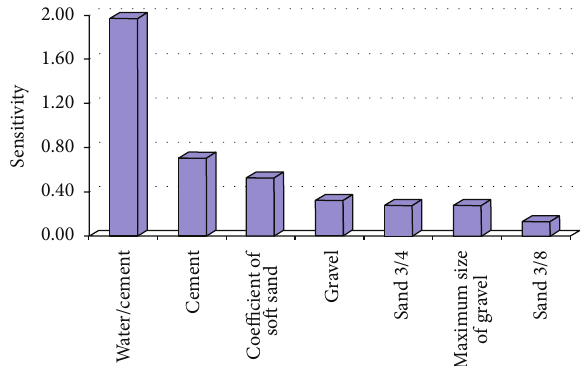
Figure4:Sensitivityanalysisofcompressivestrengthofconcretefor input parameters in MLP